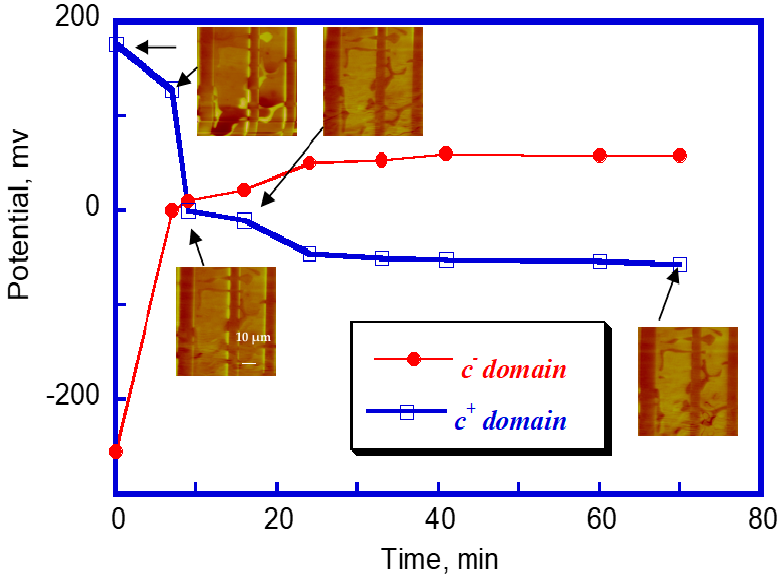
Figure 2. The c + and c − domain potential versus time showing an inversion of the potential sign, the inserted images are subsequent scans of the same area showing domain potential reversal and the decay of potential barrier. (The arrows point to the initial c + domain data points.)